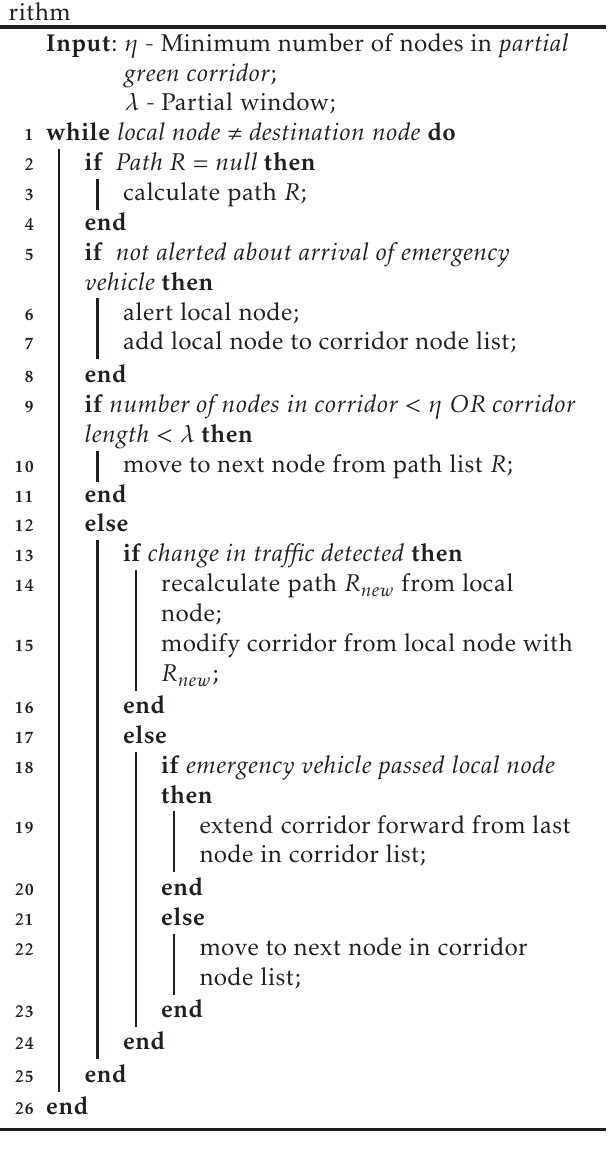
Algorithm 2: Path-Finding Agent ( PFA ) algo-